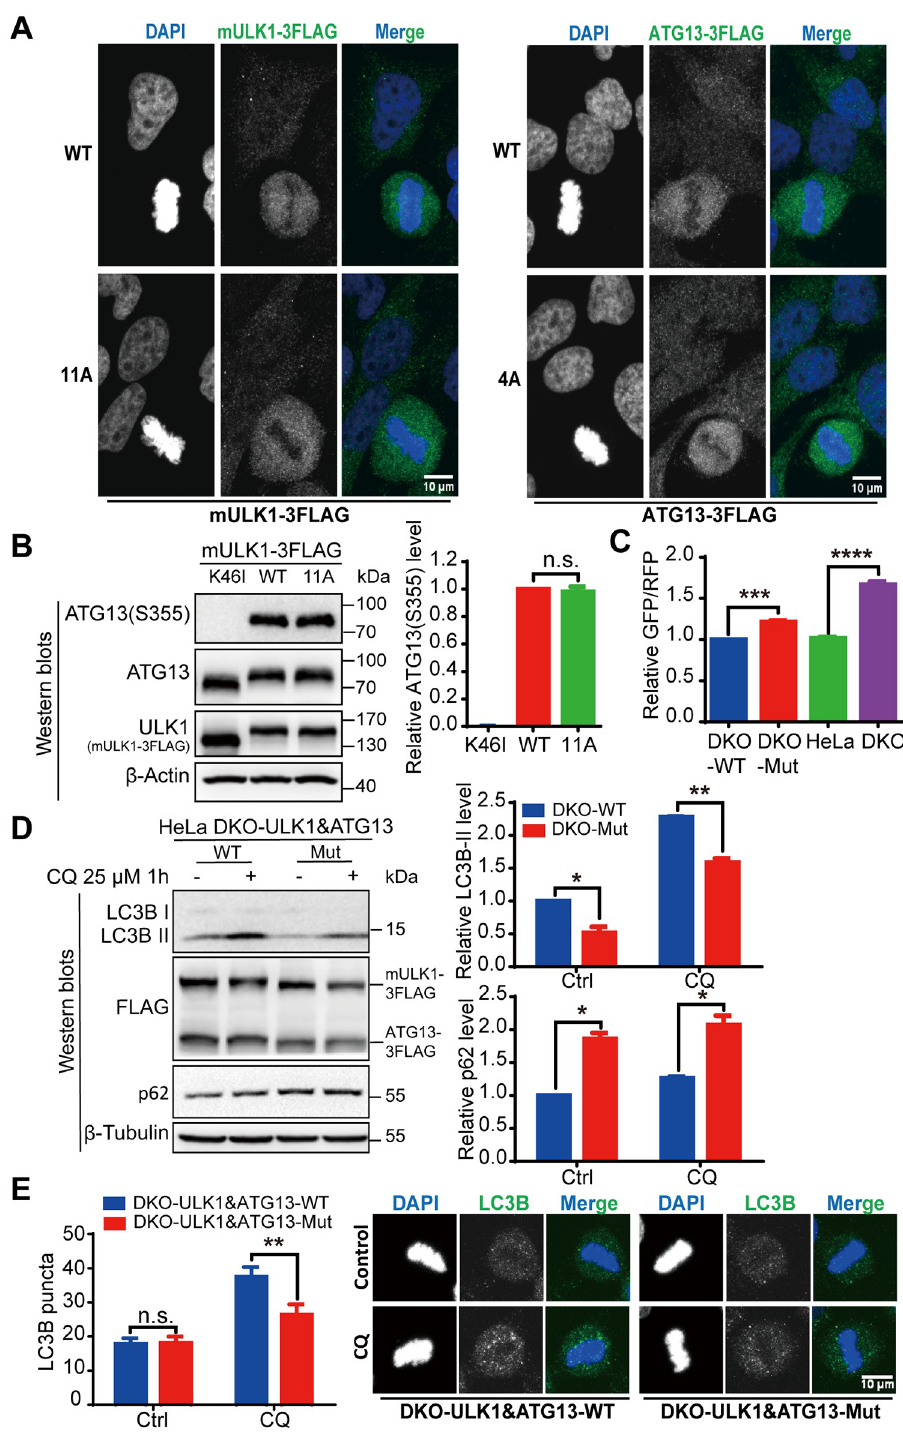
Fig 6. ULK1-ATG13 phosphorylation in mitosis promotes mitotic autophagy. (A) The localization of mutant ULK1-11A and ATG13-4A in mitosis. Cells released from thymidine block for 10 hours were fixed with 3.7% formaldehyde for 20 minutes at room temperature and then for blocking and FLAG antibody, Alexa-488 conjugated secondary antibody, DAPI staining. Scale bar, 10 μ m. (B) The ULK1 kinase activity is not affected by the 11A mutation. ATG13-Ser355 is the substrate of ULK1, which corresponds to Ser318 of ATG13 isoform 2. ULK1-KO 293T cells reconstituted with ULK1-WT, ULK1-11A, or ULK1-K46I were plated and lysed with M-PER. The western